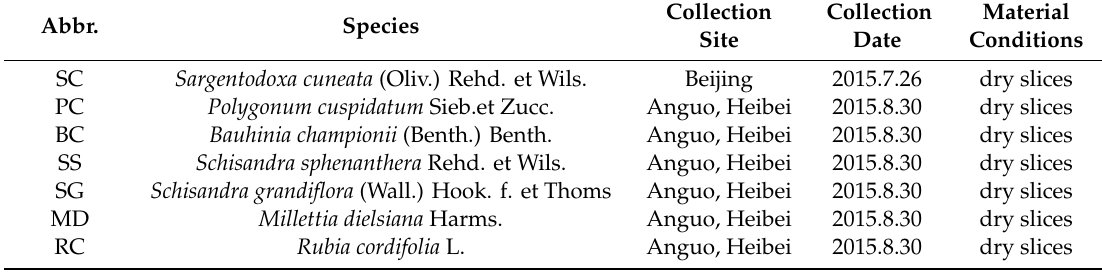
Table 3. Collected herbs: S. cuneata and its six adulterants.